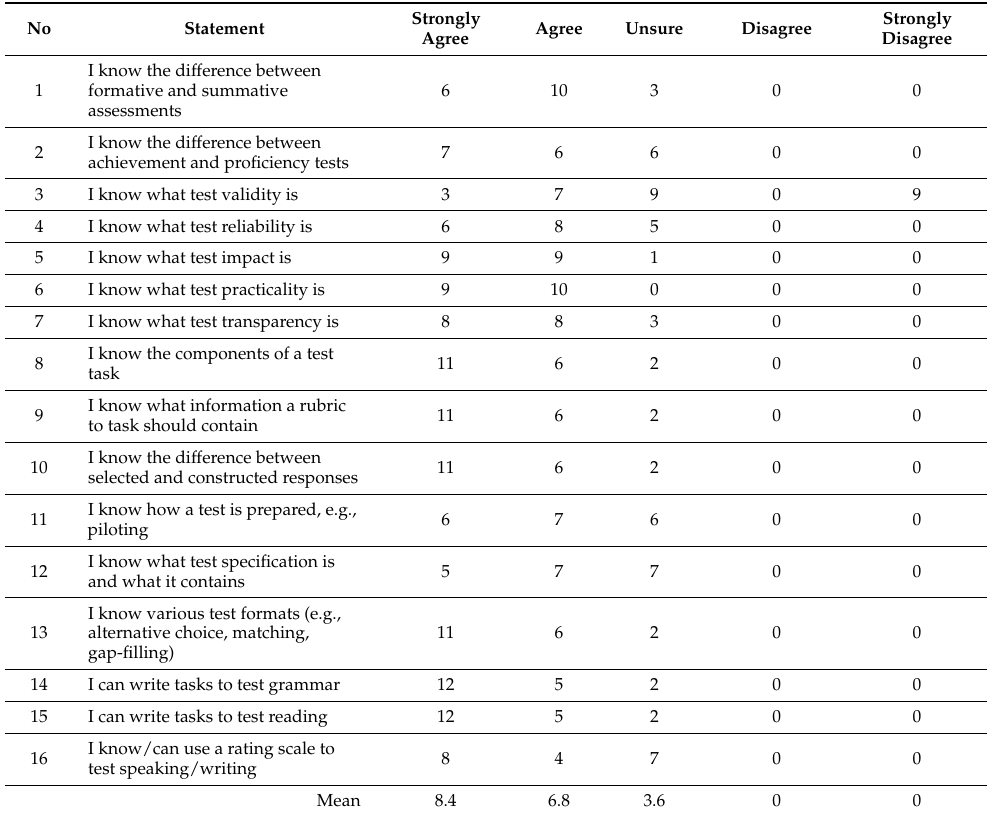
Table 4. Self-evaluation of LTA course content